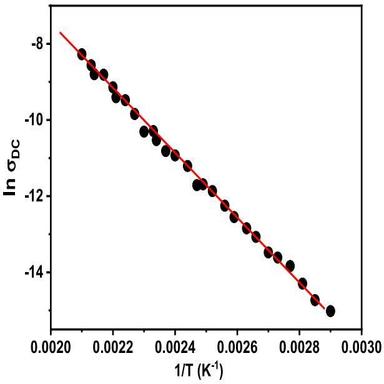
The dc electrical conductivity vs. 1/T of PVA films.